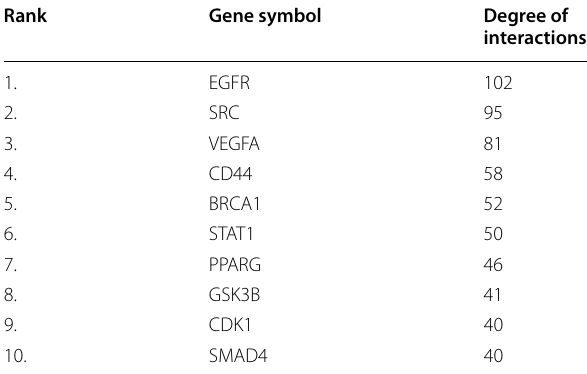
Table 1 The top 10 hub genes and their degree of interactions in the network